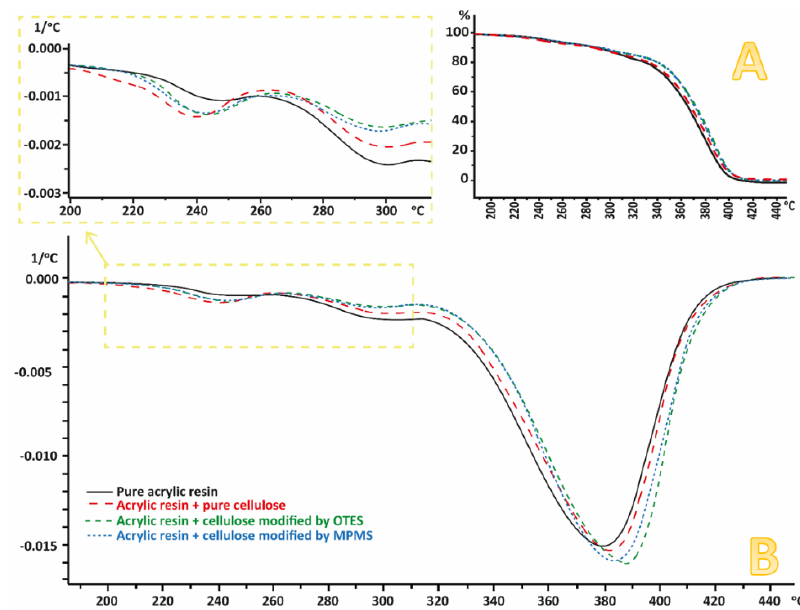
Figure 9. Results of TGA measurements: ( A ) the percentage of weight loss, ( B ) derivative of weight loss.